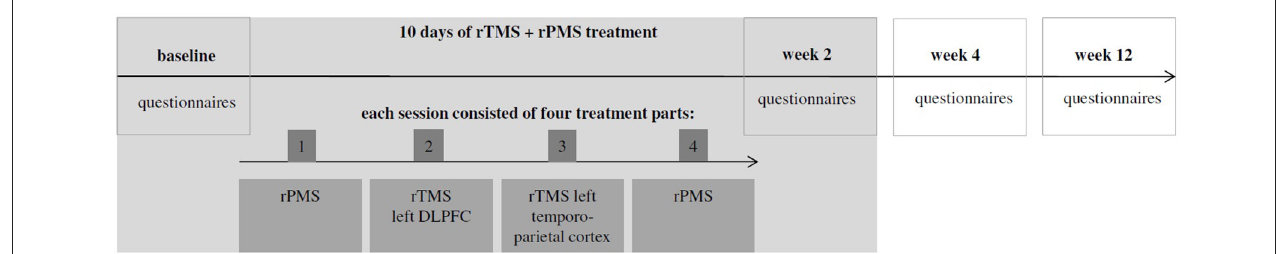
FIGURE 1 | Overall treatment